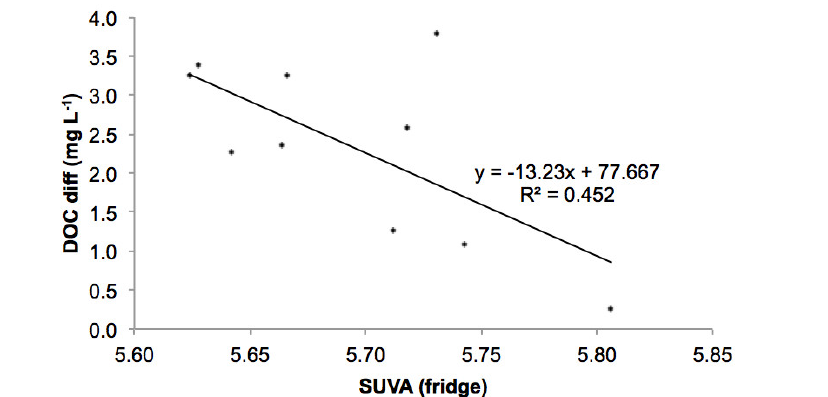
Figure 2. Relationship between SUVA 254 of the refrigerated samples and DOC concentration differences between the two storage techniques, in Experiment 1.The regression was significant ( P ≤ 0.05). The large numerical constants look implausible but are correct. They result from counterbalancing the x-multiplier and the constant over the very small x-range